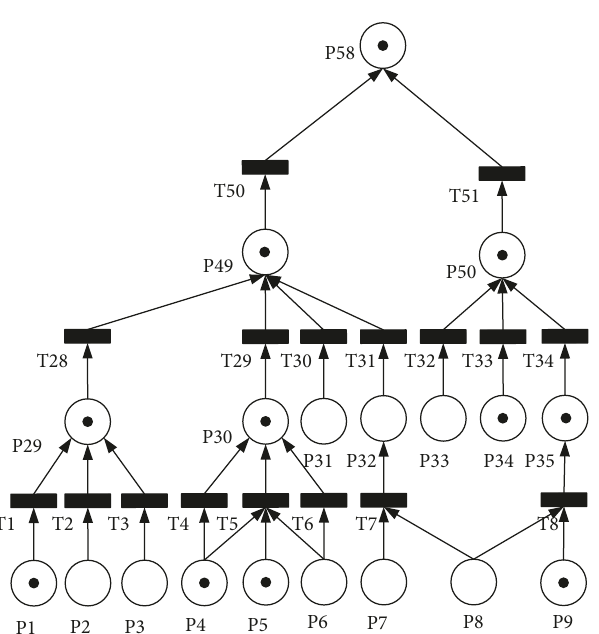
Figure 5: Token distribution after forward